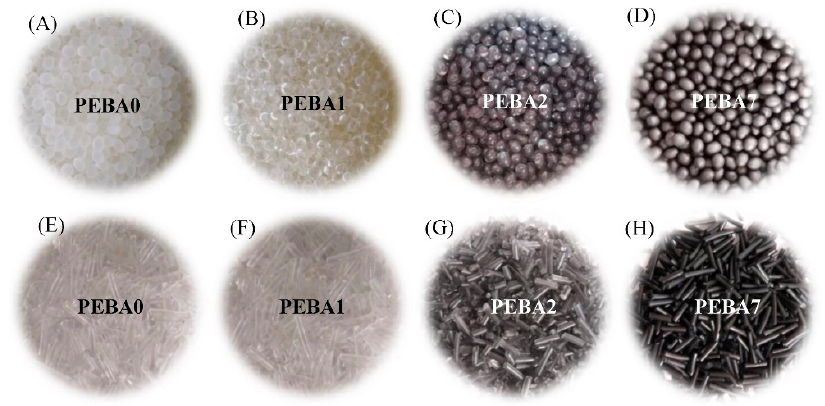
Figure 2. Images of ( A – D ) the pre-mixed GA/PEBA pellets and ( E – H ) the extruded GA/PEBA granules.